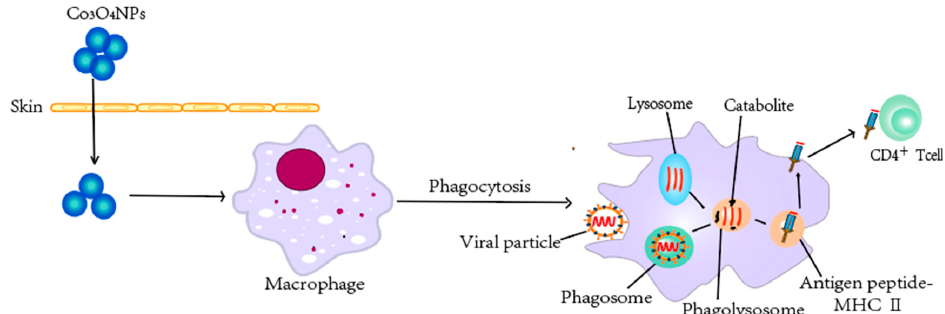
Figure 5. Cobalt nanomaterials help to enhance immunization efficacy. Co3O4NPs can penetrate human skin and introduce considerable immunostimulatory when pulsed with macrophages. Mac-